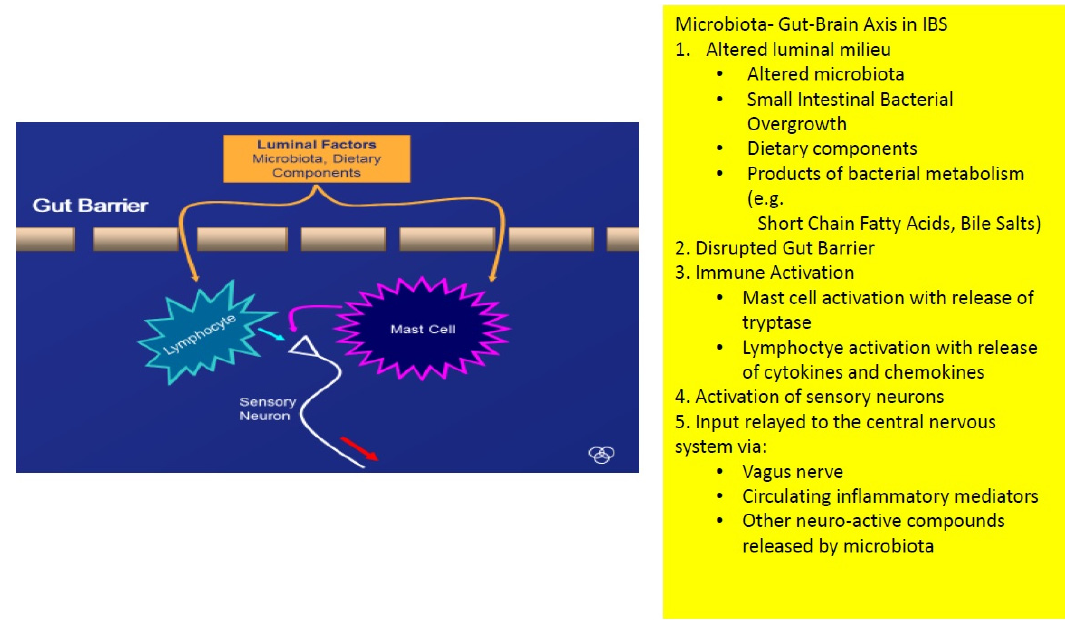
Figure 2. How the microbiota ‐ gut ‐ brain axis might operate in irritable bowel syndrome.